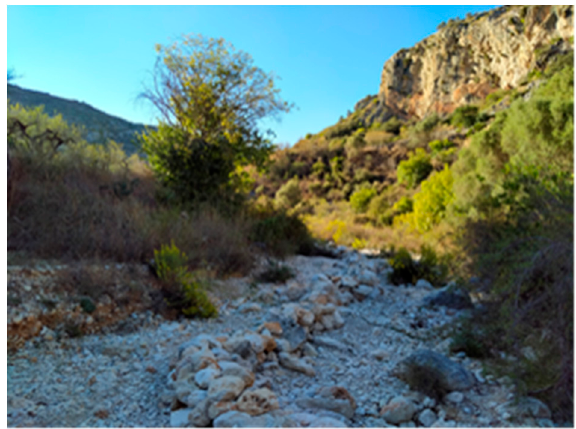
Figure 15. The river that borders the arrival roads and the paintings place. The photo is taken by the author.